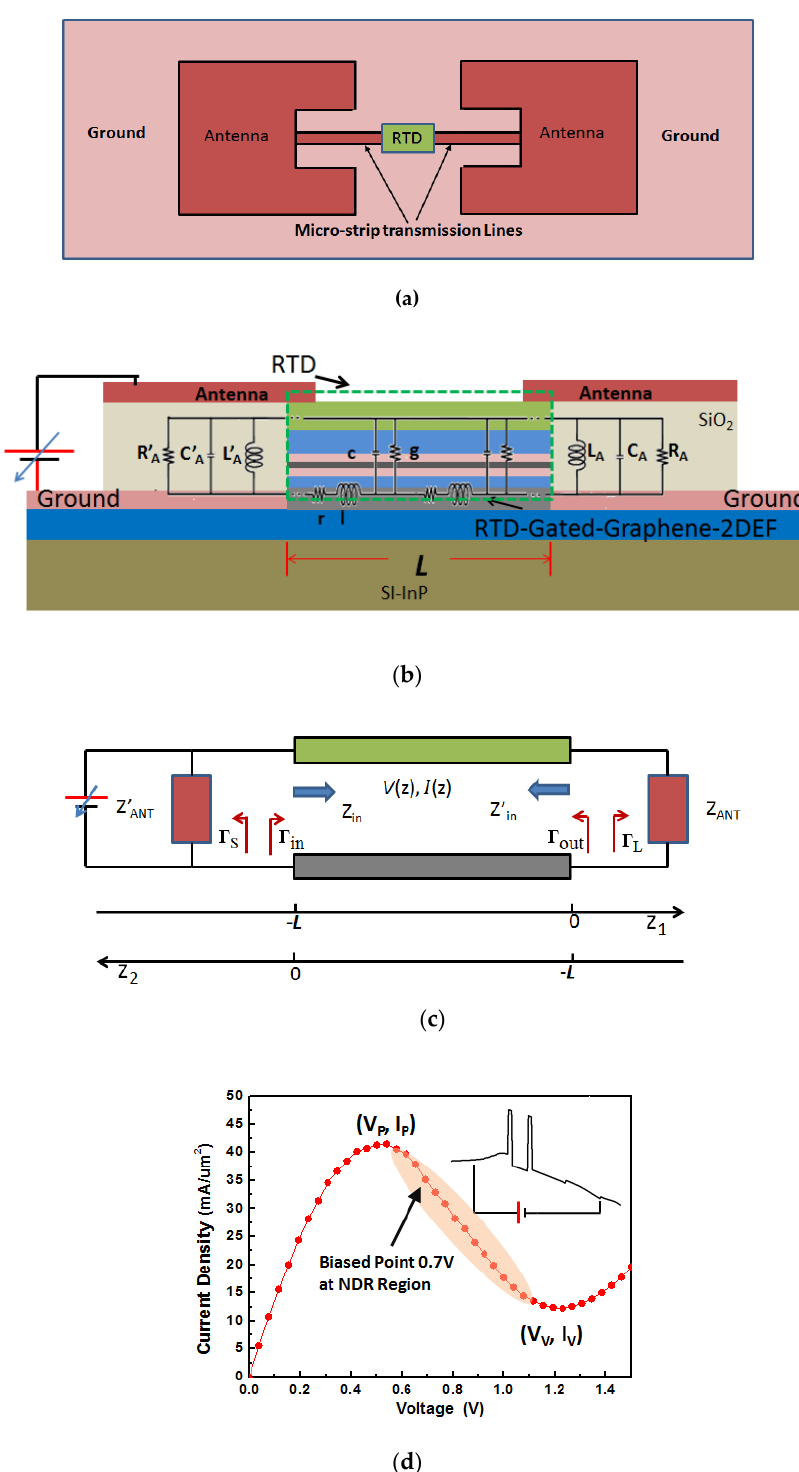
Figure 1. ( a ) Top view of resonant tunneling diode (RTD) terahertz oscillator. The developed oscillator comprises a RTD, RTD-gated-graphene-2DEF, and two graphene antennas. ( b ) Cross-section of RTD terahertz oscillator. Distributed transmission line model of RTD-gated-graphene-2DEF (two dimensional electron fluid) RTD oscillator. ( c ) Equivalent active transmission line oscillator model. ( d ) I-V characteristic of the